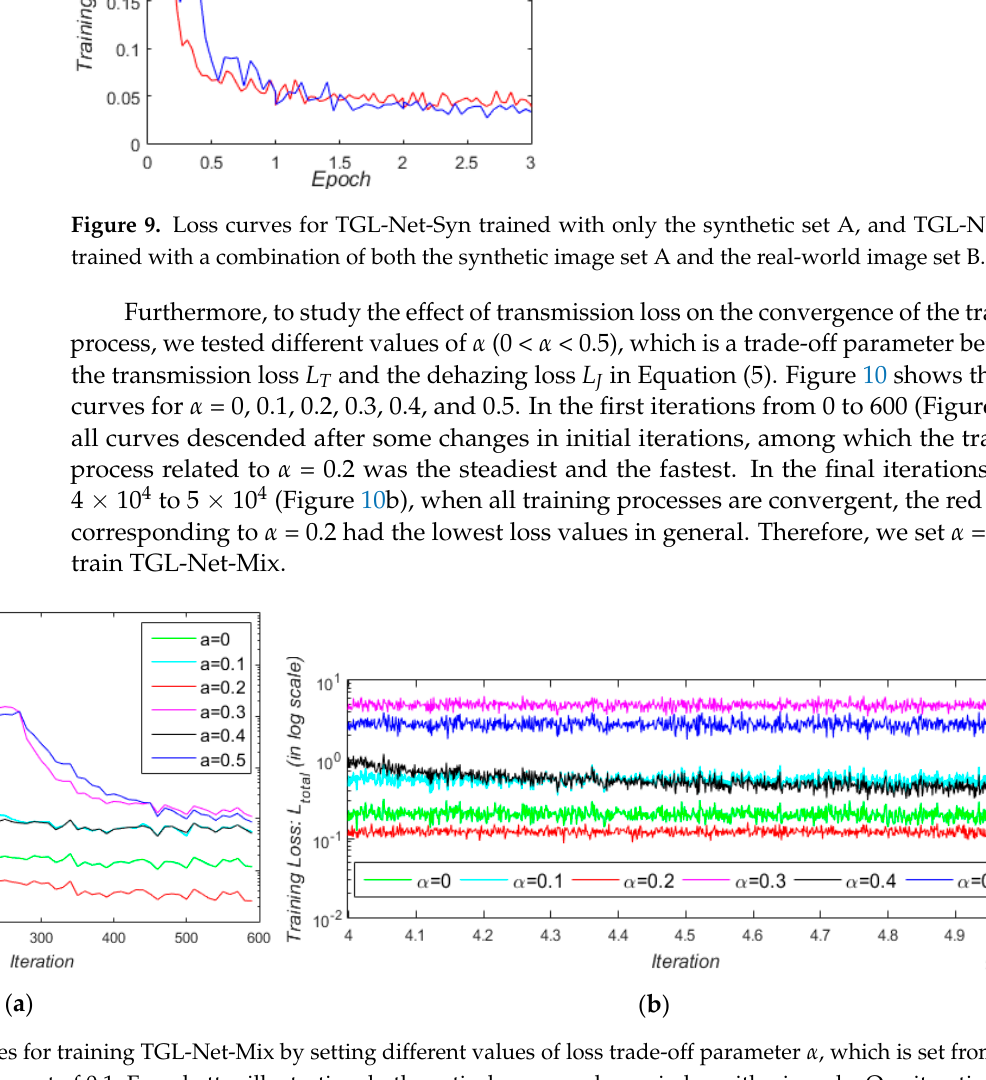
( b ) Figure 11. Loss curves for training the proposed network with ReLU and ELU activations, respectively. ( a ) Loss curve in iterations from 0 to 400; ( b ) loss curve in iterations from 7 × 10 4 to 8 × 10 4 .